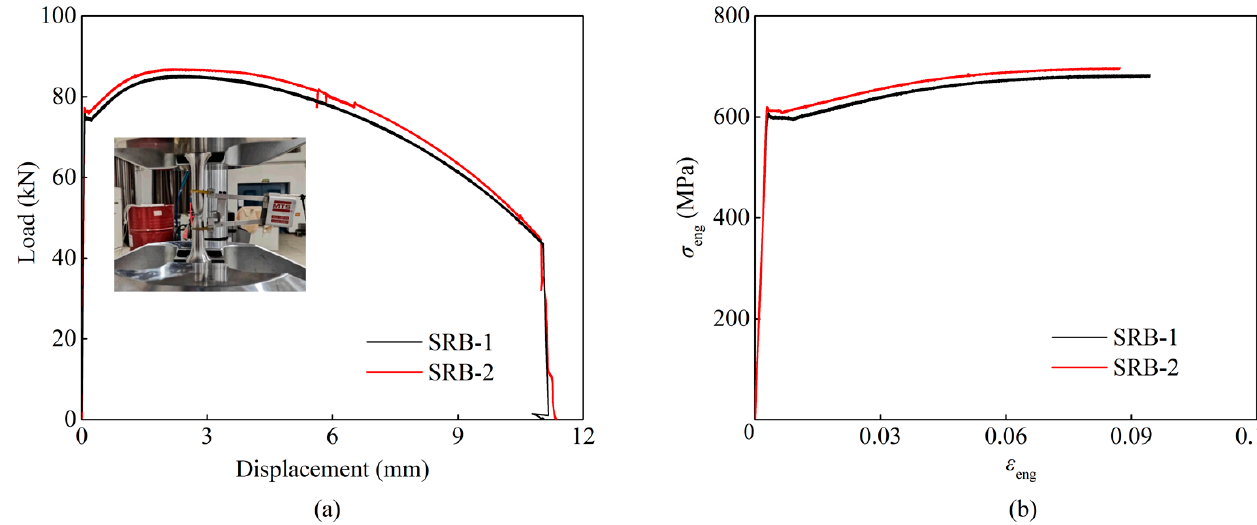
Figure 4. The results of the material property test for X80 pipeline steel: ( a ) the load-displacement curves; ( b ) the engineering stress-strain curve. Table 1. Mechanical properties of X80 pipeline steel.